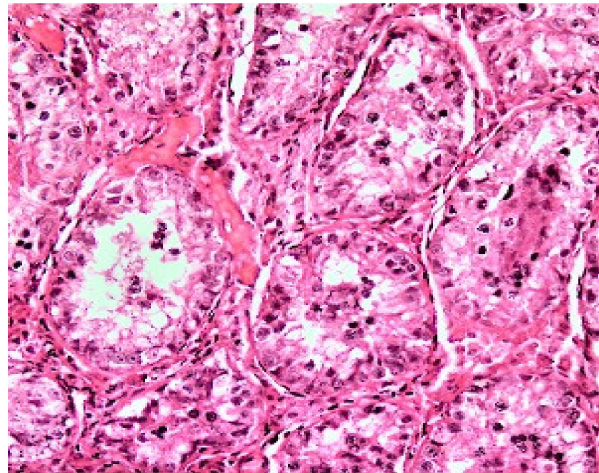
Figure2. Histologyoffreshtesticulartissue(sectionsofseminiferoustubules)fromanadultblack-footed ferret. Bar = 20 µ m.